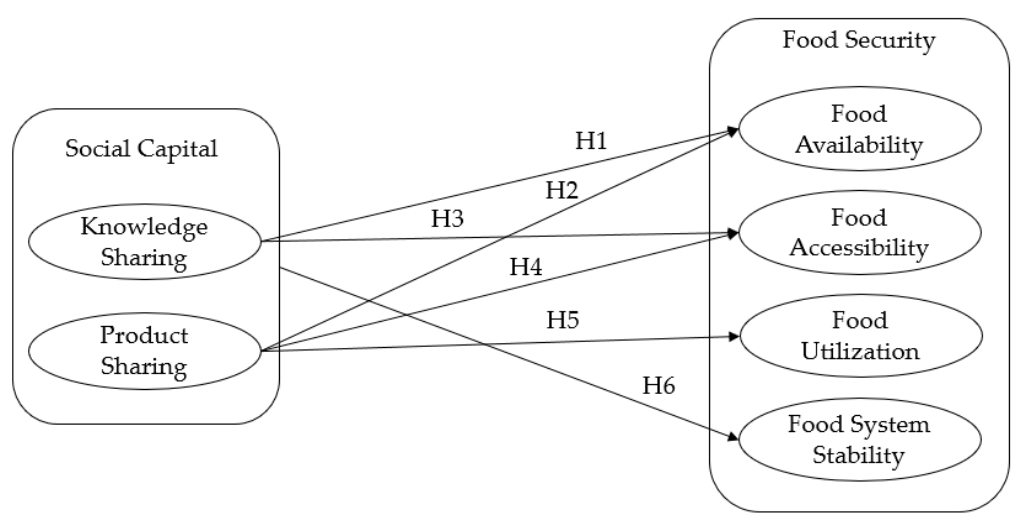
Figure 6. Conceptual model of the study; the e ff ect of social capital on food security. H1: Social capital improves food availability through sharing knowledge among members of a community;.H2: Social capital improves food availability through sharing products among members of a community; H3: Social capital improves food accessibility through sharing products among members of a community; H4: Social capital improves food accessibility by sharing knowledge among members of a community; H5: Social capital improves food utilization through sharing products among members of a community; H6: Social capital activities strengthen food system